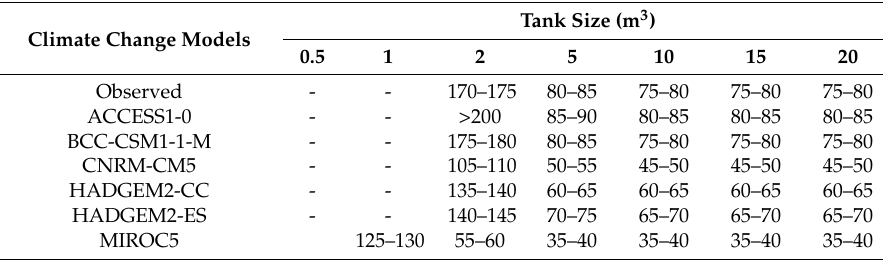
Table 3. Roof size requirement during JJA for 80% reliability (2025–2055).